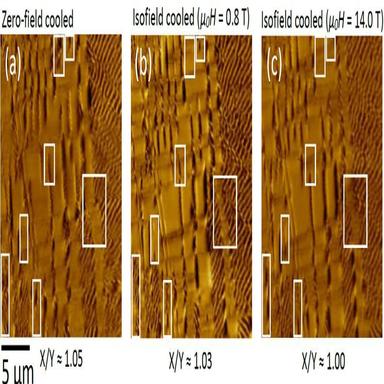
Comparing the X-type and the Y-type twinning configuration portions in the same scan area of the sample via MFM images at 300 K for different cooling conditions: a) zero-field cooled, b) isofield cooled at μ0H = 0.8 T applied normal to the film plane, c) isofield cooled at μ0H = 14.0 T applied normal to the film plane. Some of the minor differences between the images are highlighted by the white frames.